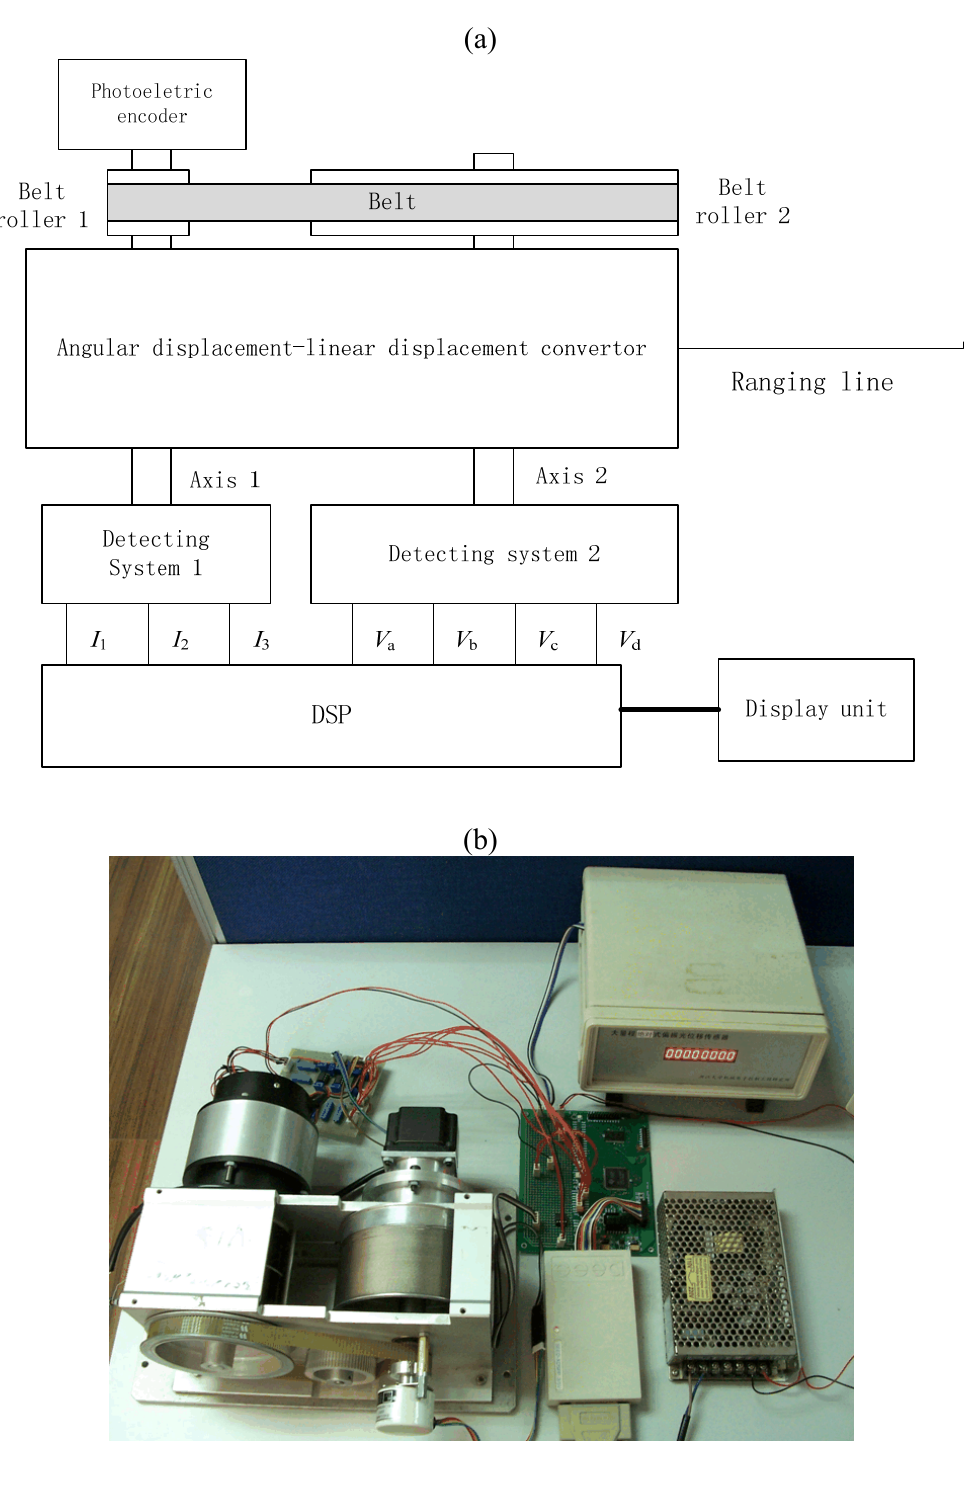
Figure 5. (a) Installation diagram of the prototype and test bed. (b) Entity of the prototype and the test bed. (c) Measured signals of light intensity from detecting system 1 as a response of the input angular displacement. (d) Measured signals of light intensity from detecting system 2 as a response of the input angular